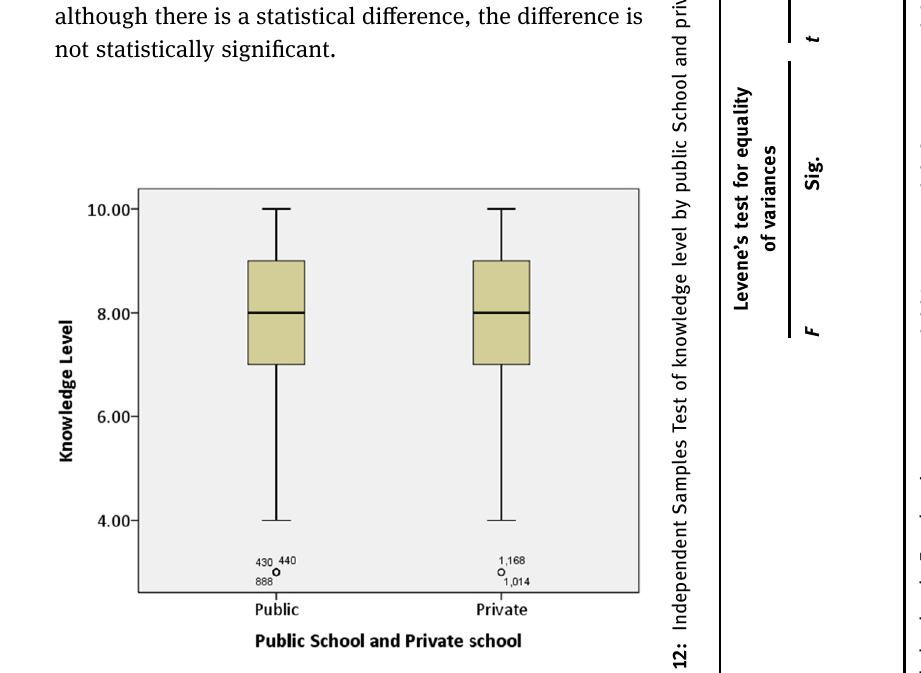
Figure 7: Student ’ s knowledge level by public school and private